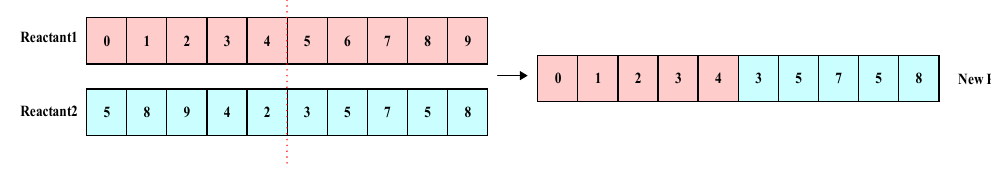
Figure 7. Synthesis reaction operation representation.